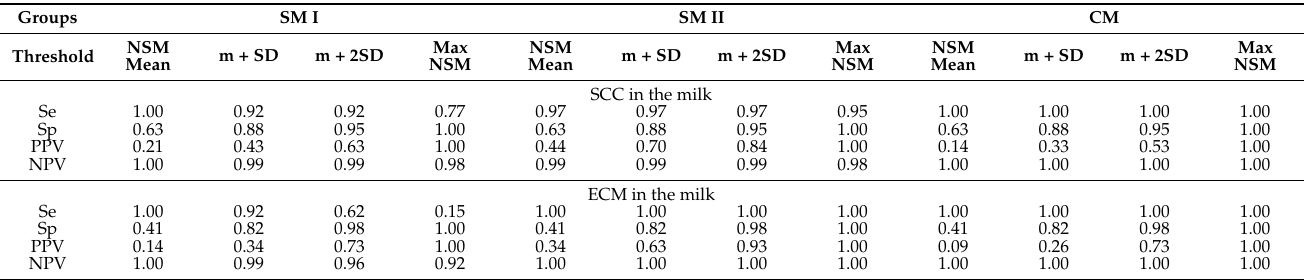
Table 1. The sensitivity (Se), specificity (Sp), positive predictive value (PPV), and negative predictive value (NPV) of mastitis detection in the first subgroup with subclinical symptoms of mastitis (SM I), the second subgroup with subclinical symptoms of mastitis (SM II), and the group with clinical symptoms of mastitis (CM) based on the values of the somatic cell count (SCC) and electrical conductivity of milk (ECM) in the equine milk. The Se, Sp, PPV, and NPV were estimated based on four thresholds representing the group with no subclinical symptoms of mastitis (NSM); NSM mean; NSM mean + SD (m + SD); NSM mean + 2SD (m + 2SD); the maximal value of each milk indicator for the NSM group (max